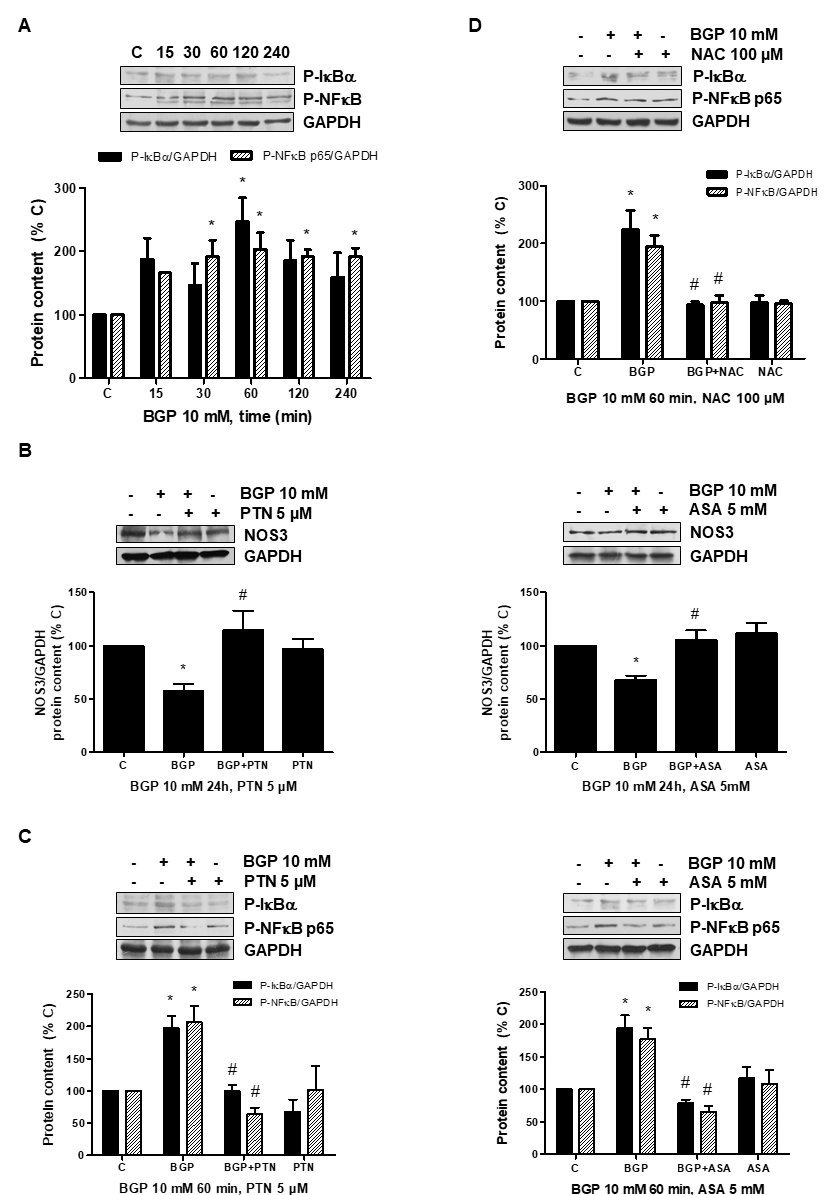
Figure 6. BGP-induced NOS3 downregulation depends on oxidative stress-induced NFκB activation in human endothelial cells. A human endothelial cell line (EA.hy926) was treated with 10 mM BGP. ( A ) Phosphorylation of IκB and NFκB p65 was studied by expression of Ser32 P-IκB and Ser536